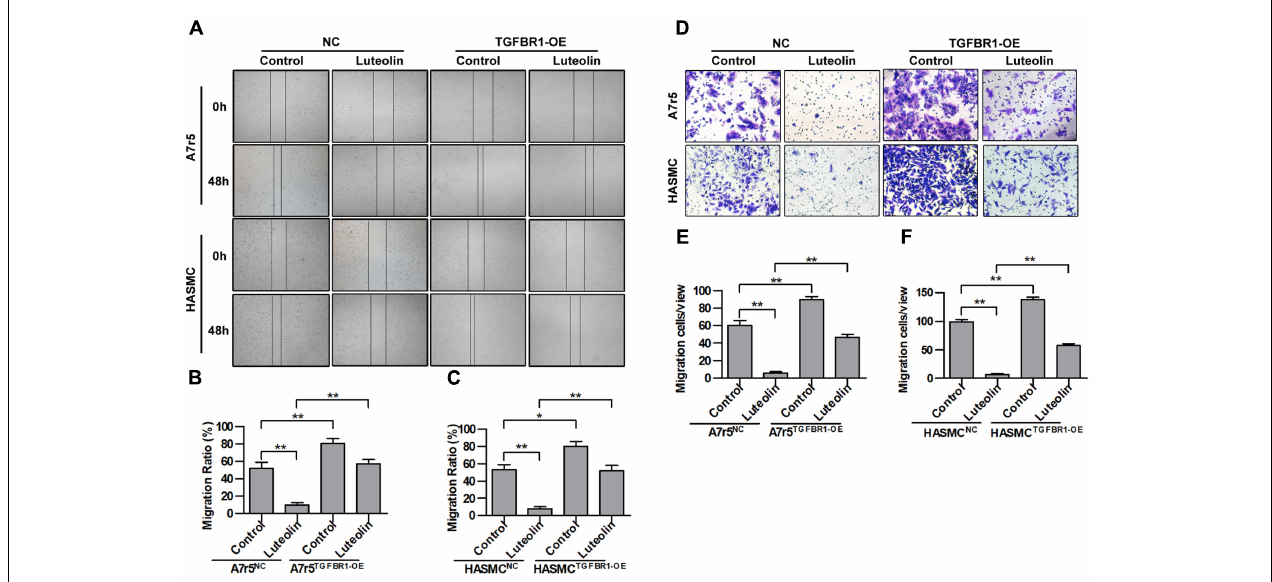
FIGURE 6 | Overexpression of TGFBR1 partially blocks the inhibitory effect of luteolin on vascular smooth muscle cell (VSMC) migration. (A) A7r5 and HASMC cells were incubated with TGFBR1 overexpression adenovirus vector and GFP control adenovirus for 48 h and then treated with luteolin (40 µ M) for 24 h. Then, the migration of VSMCs was tested by wound healing assays. (B , C) Percentage of relative VSMC migration ( n = 3). (D) A7r5 and HASMC cells were incubated with TGFBR1 overexpression adenovirus vector and GFP control adenovirus for 48 h. Then, Transwell assays were performed after treatment with luteolin (40 µ M) for 12 h. (E , F) The number of cells in each field of view ( n = 5). Data are shown as the mean ± SD. ∗ P < 0.05, ∗∗ P < 0.01.